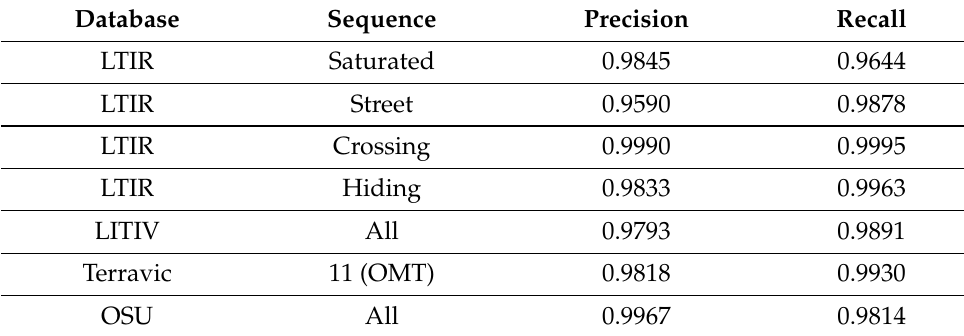
Table 5. Detection results on all datasets used in the